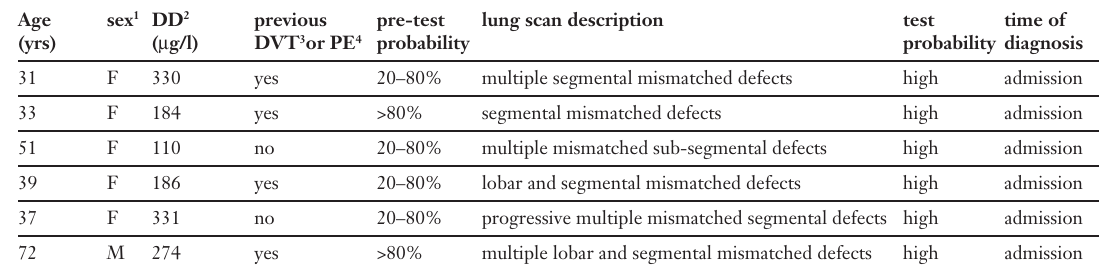
Characteristics of the six patients with a negative DD test and a final diagnosis of PE.